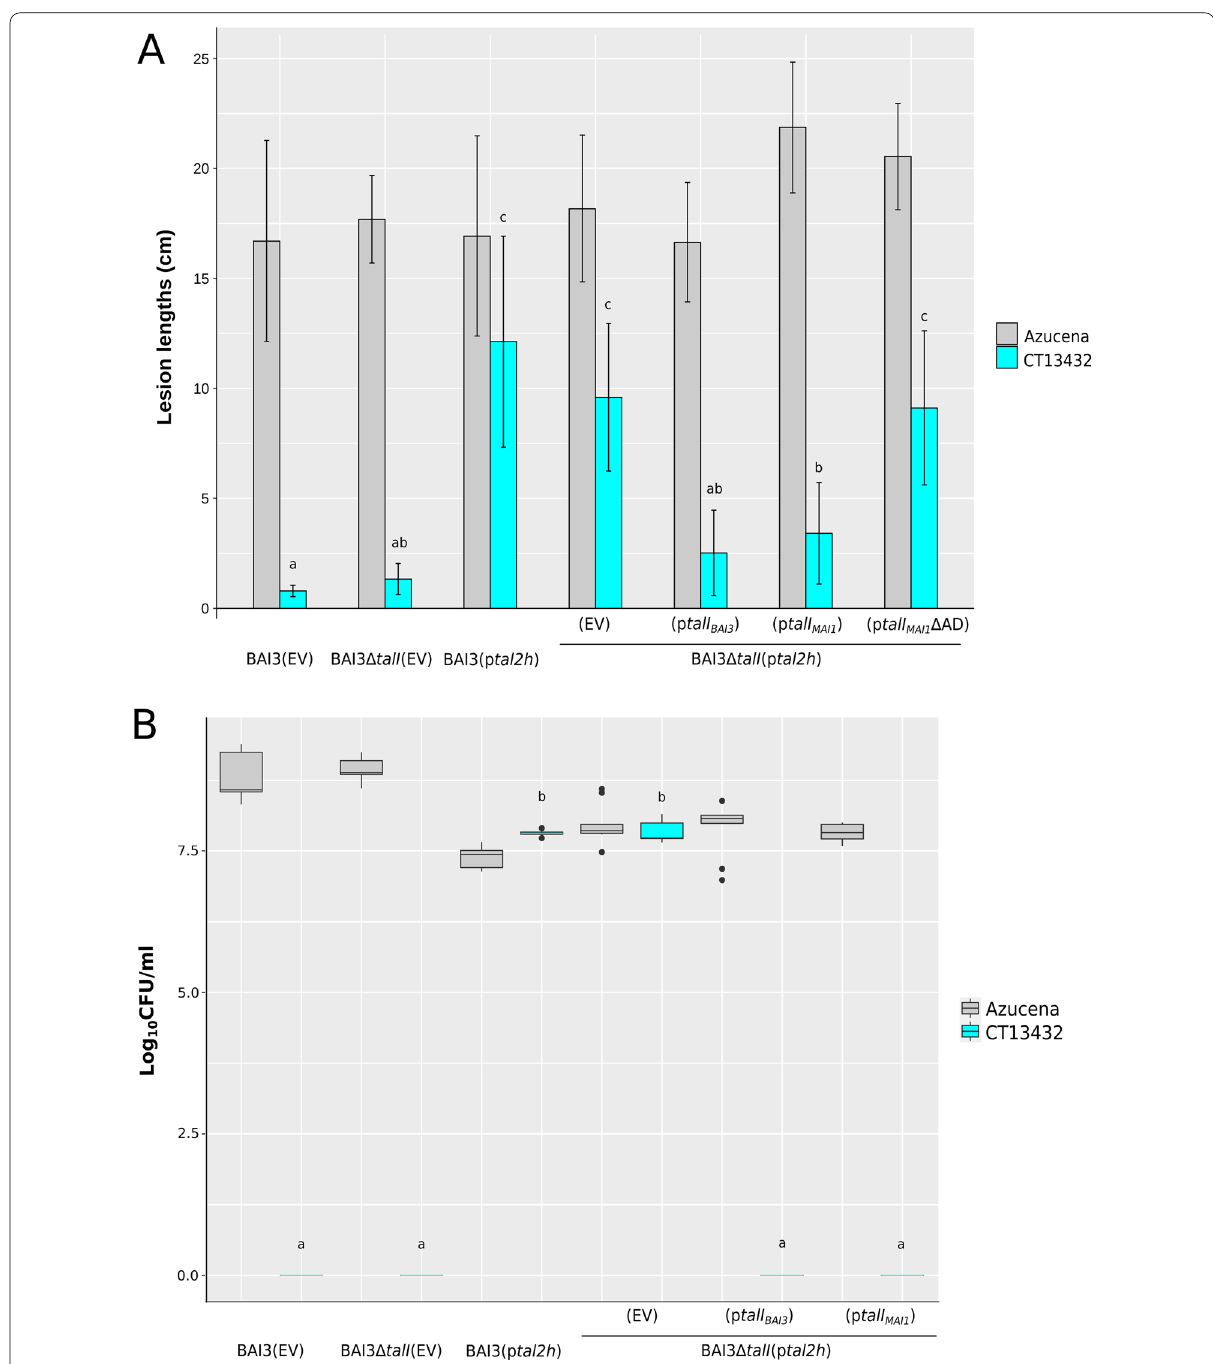
Fig. 4 Suppression of Xa1-like resistance unmasks TalI avirulence activity in the rice variety CT13432. A Leaves of CT13432 and Azucena plants were clip-inoculated with the Xoo strain BAI3 carrying the pKEB31 empty vector (EV), the BAI3Δ talI mutant carrying the pKEB31 empty vector (EV) , the BAI3 strain expressing the tal2h truncTALE , and BAI3Δ talI expressing tal2h and the pSKX1 empty vector (EV), or pSKX1 containing talI BAI3 , talI MAI1 or talI MAI1 ΔAD. Lesion lengths were measured at 15 dpi. Data are the mean of eight measurements. B Bacterial counts were taken 7 dpi of rice leaves of CT13432 and Azucena inoculated with the same panel of Xoo strains used in ( A ). Statistical tests in both experiments were carried out in R using the nonparametric Kruskal–Wallis and Dunn’s tests (α 0.05). Values labeled with the same lower-case letter are not significantly =